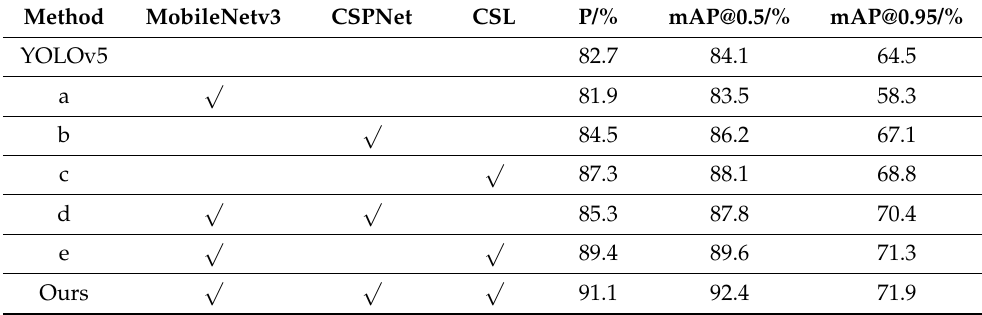
Table 3. Experimental comparisons of each combination in the feature extraction network.